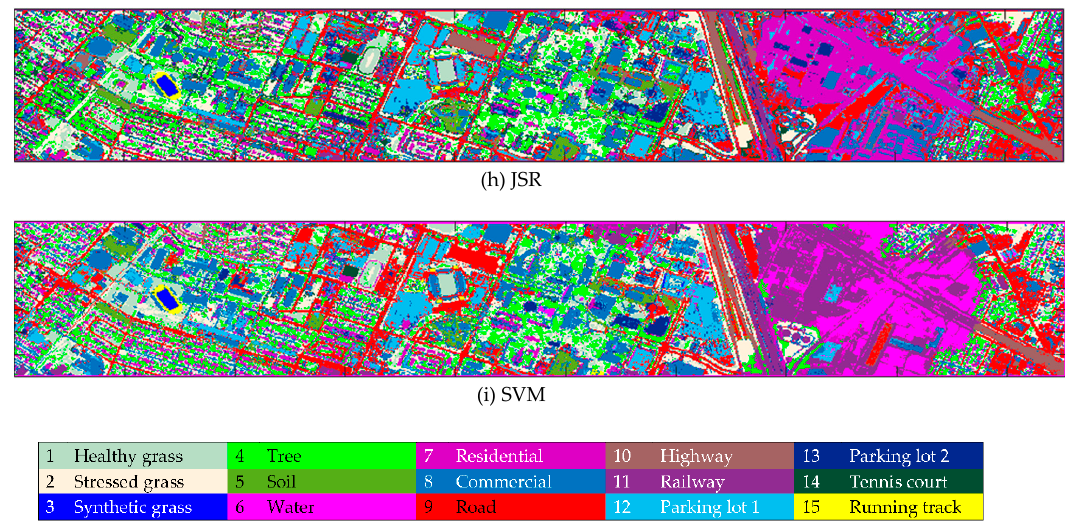
Figure 2. DS-44 band classification maps for (a) ASD, (b) MSD, (c) RXD, (d) KASD, (e) KMSD, (f) KRXD, (g) SR; (h) JSR; and, (i) SVM.